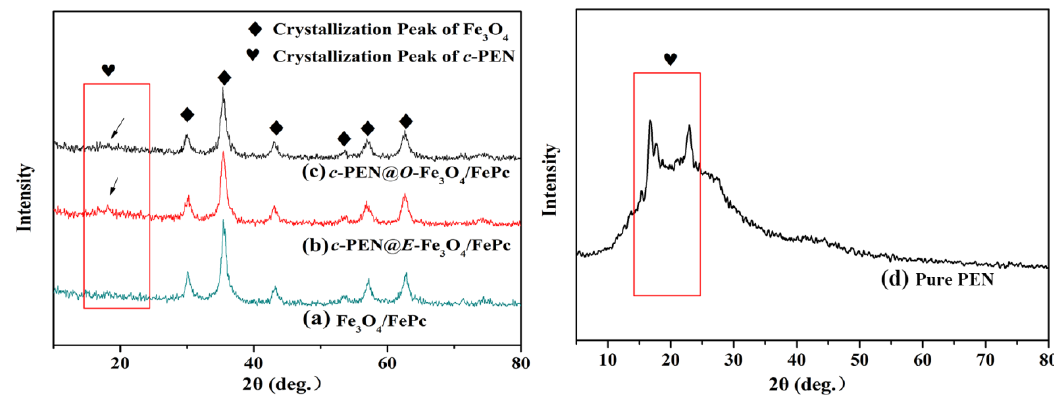
Figure 5. XRD curves of: ( a ) E-Fe3O4/FePc, ( b ) c -PEN@E-Fe3O4/FePc, and ( c ) c -PEN@O-Fe3O4/FePc, ( d ) pure PEN.